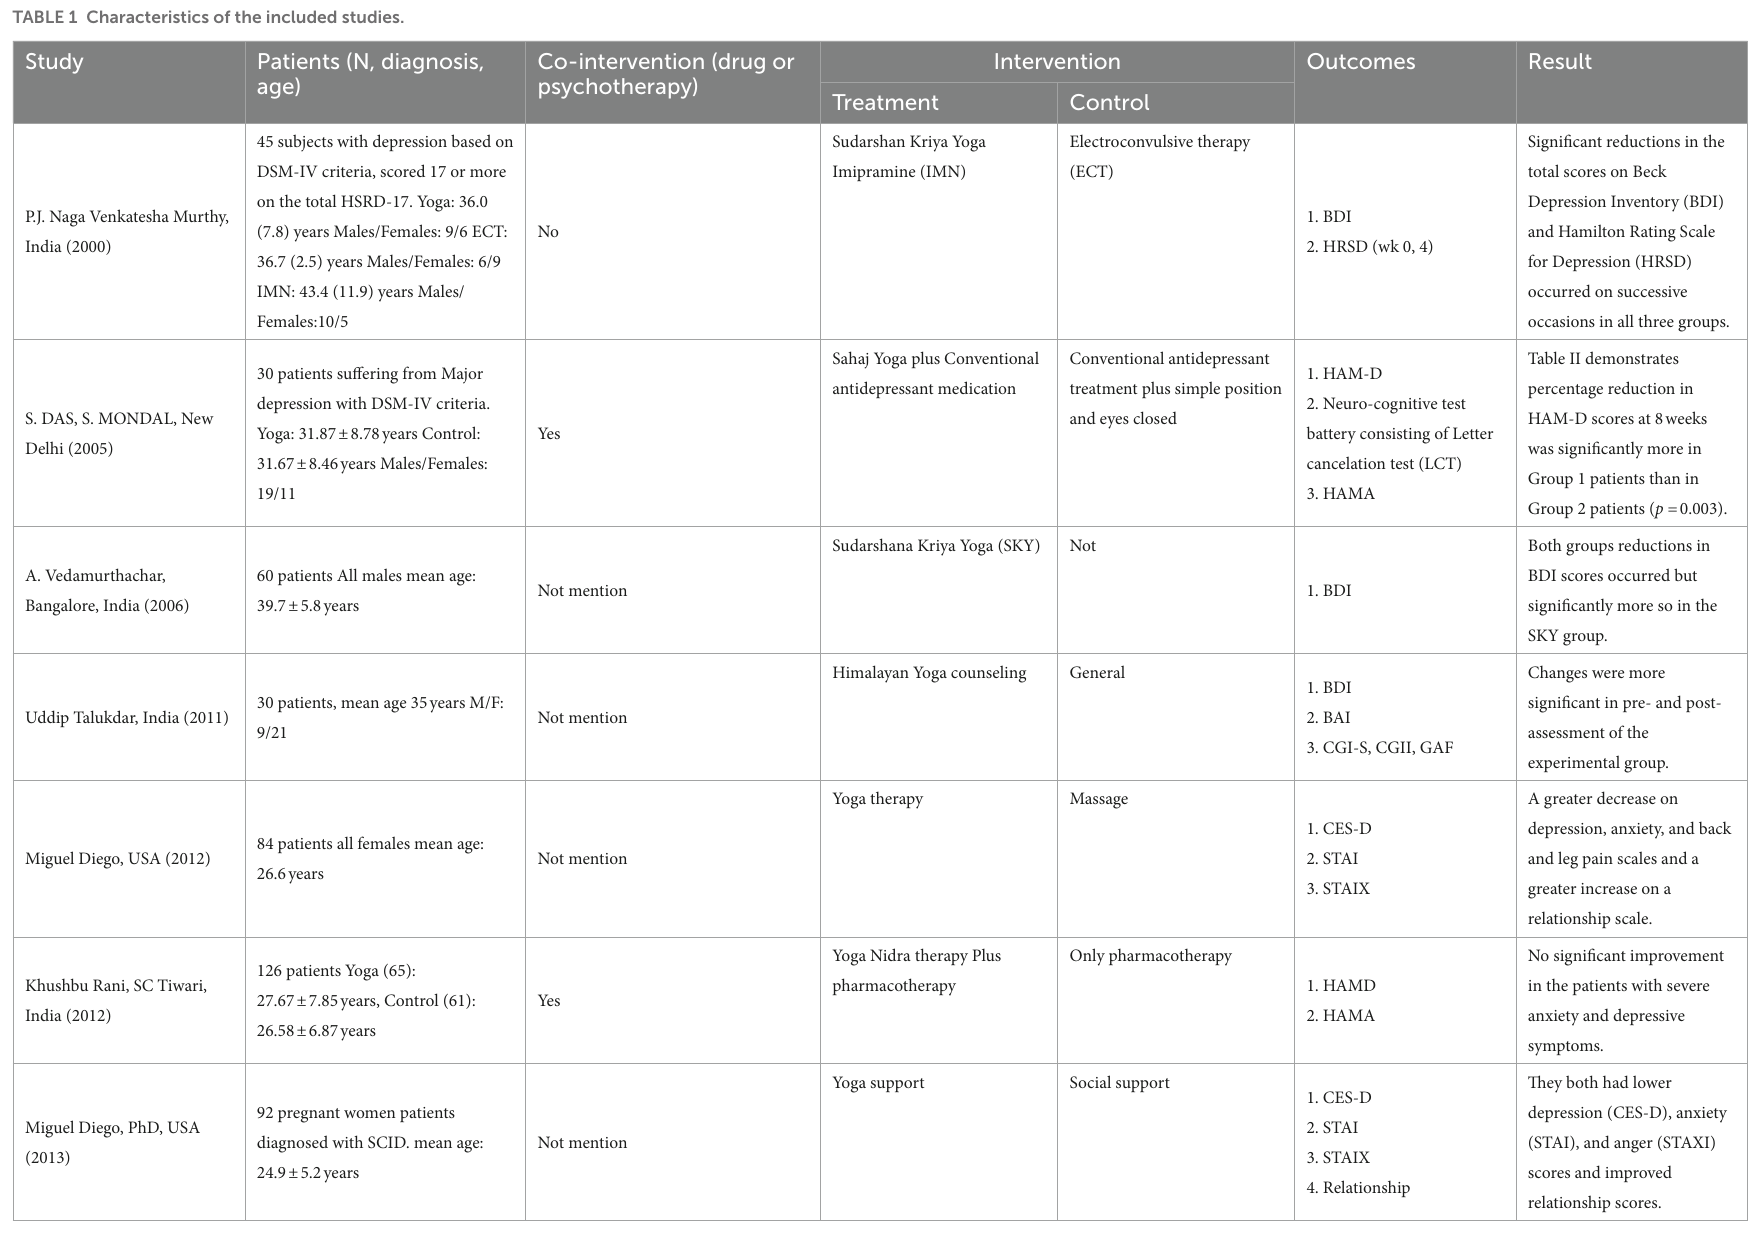
TABLE 1 Characteristics of the included